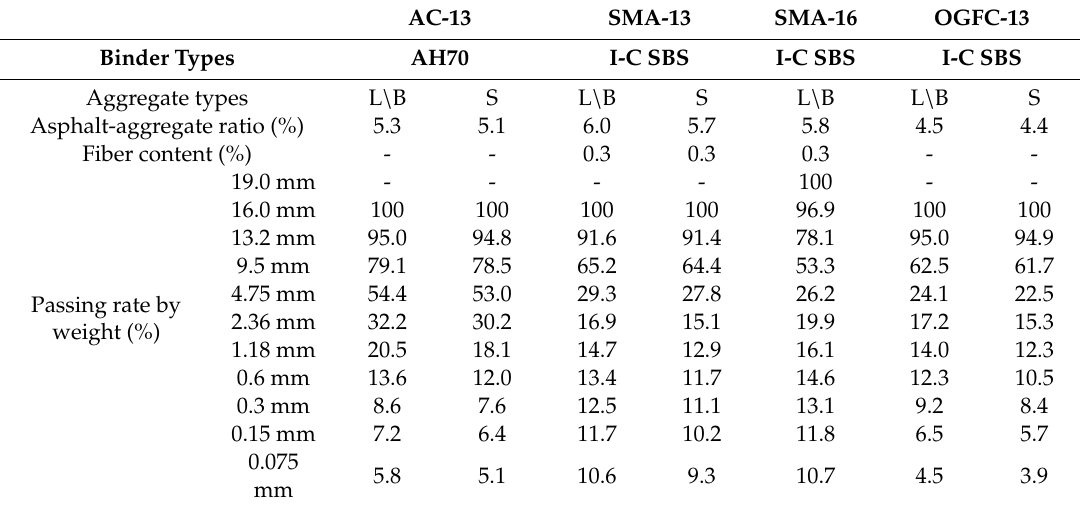
Table 1. Gradation composition of asphalt mixture specimens.